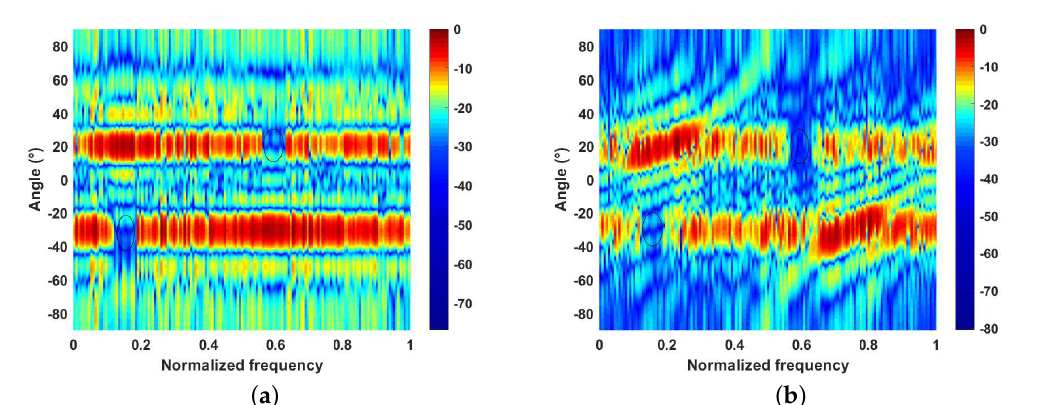
Figure 9. The power distributions in the space–frequency domain. ( a ) The result of the proposed method. ( b ) The result of the QA-ADMM.